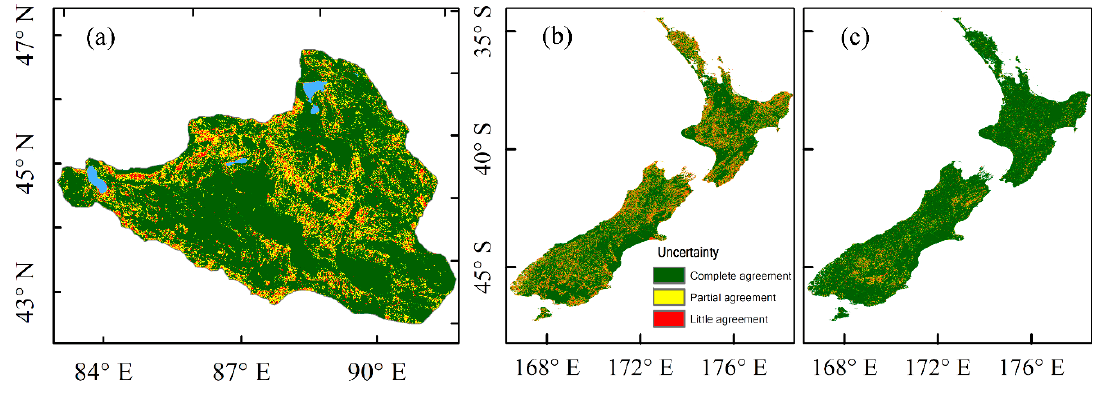
Figure A1. Uncertainty maps of ( a ) vegetation subtypes (DzB), ( b ) vegetation classes (NZ), and ( c ) habitats (NZ). Little agreement represents 0 ≤ CI ≤ 0.66; partial agreement represents 0.66 < CI ≤ 0.90; and complete agreement represents 0.90 < CI ≤ 1.